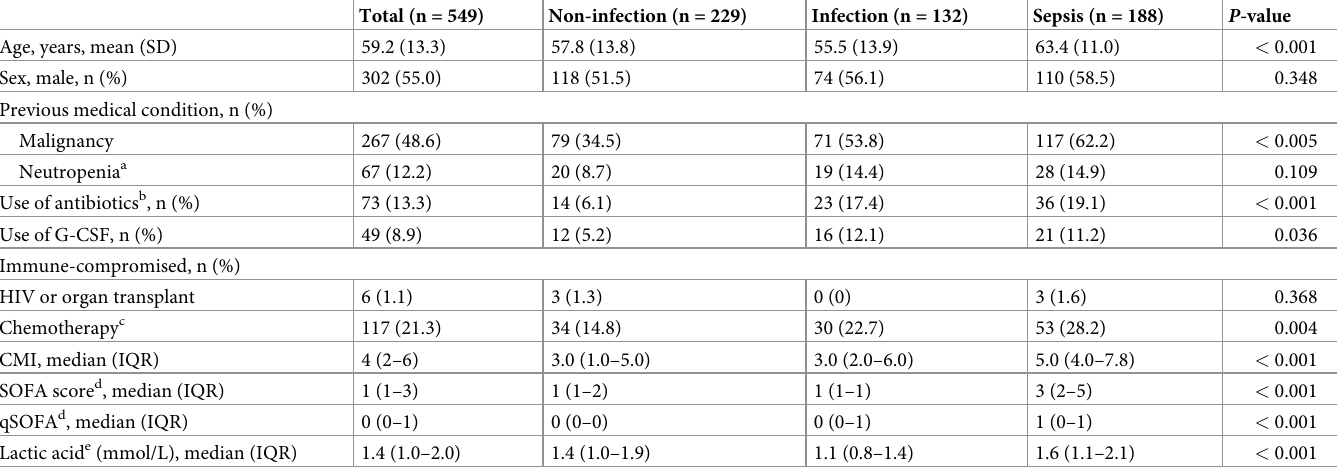
Table 1. Baseline clinical characteristics of patients visiting the emergency department.